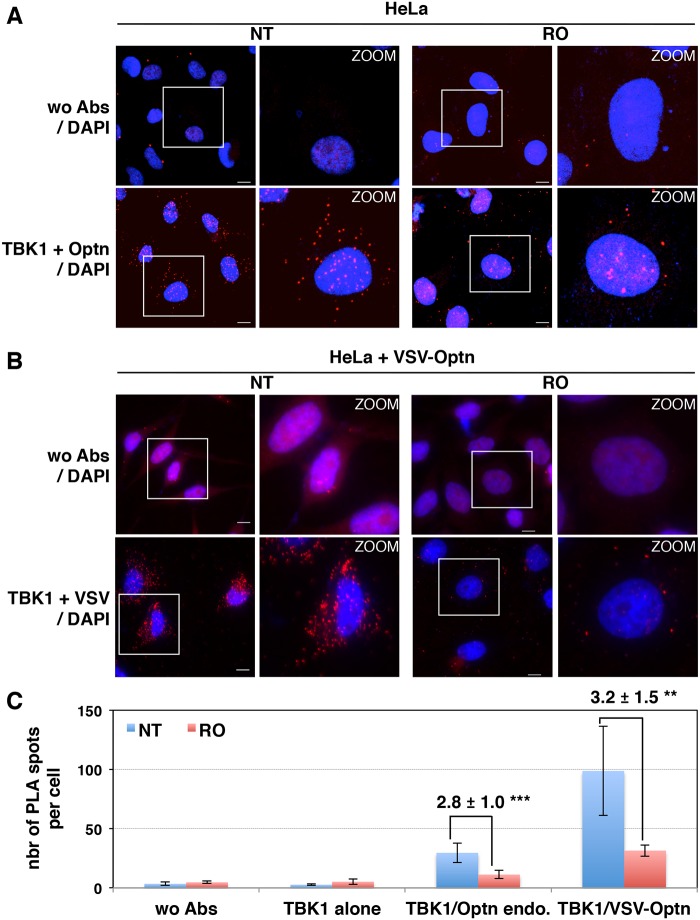
Interaction between TBK1 and Optn is prevented in G2/M synchronized cells.HeLa cells (A) and Optn-deficient HeLa cells expressing VSV-Optn (B), left untreated (NT) or synchronized in G2/M by RO-3306 (RO), were analyzed by in situ proximity ligation assays (PLA) using anti-TBK1 and anti-Optn (in A, lower panels) or anti-VSV (in B, lower panels) antibodies. Control PLA experiments were performed in the absence of antibodies (wo Abs, A and B, upper panels). Magnified views (x5 zoom factor) of the white square area are presented. Bars = 10 μm. (C) Quantification of the number of PLA spots per cell. In each condition, an average of 23 to 158 cells was imaged and 200 to 10.000 spots were counted using Imaris. Fold differences between PLA spots/cell observed with TBK1/Optn antibodies in HeLa cells (in A) or with TBK1/VSV antibodies in HeLa cells (in B) relative to the spots observed in the absence of antibodies (wo Abs) are indicated. p values < 0.01, *** p values < 0.001.